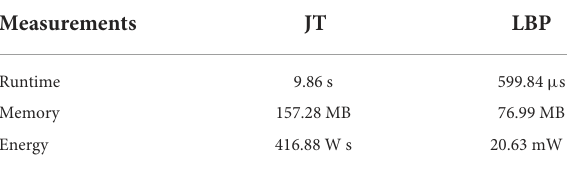
TABLE 5 Comparison of the two methods on a data set with a grid independence structure sized 14 ×